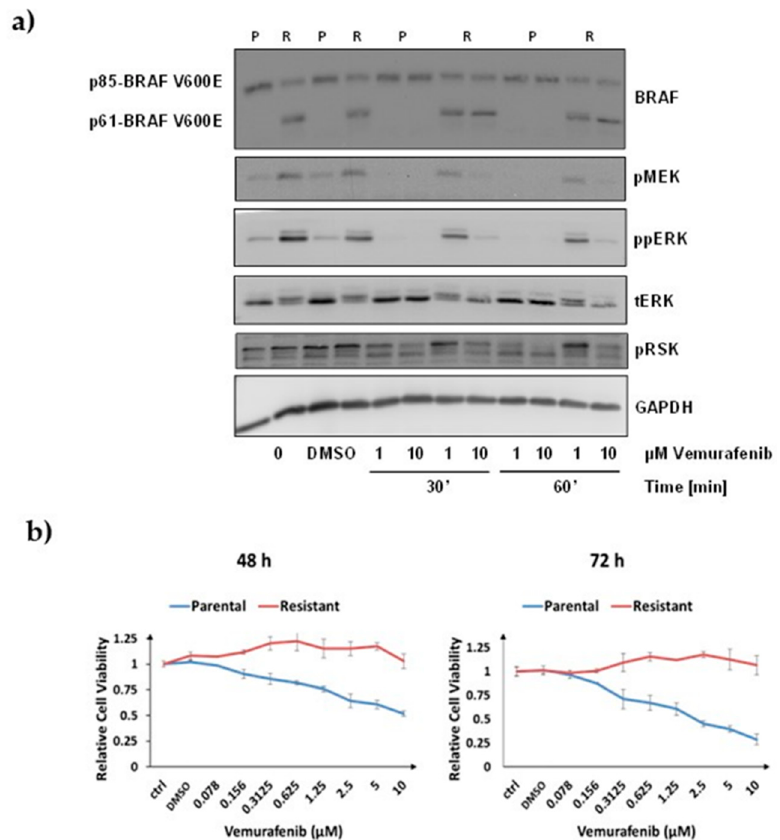
Figure 1. Characterisation of the cell line model system. ( a ) Western blot of ERK signalling in response to vemurafenib treatment. Treatment doses and timepoints in parental (P) and resistant (R) SK-MEL-239 cells are indicated below the image. p85-BRAF indicates full-length BRAF V600E of 85 kDa, and p61 the short splice variant of 61 kDa. ( b ) Relative cell viability measured by MTS assay in response to different doses of vemurafenib treatment for 48 h and 72 h, as indicated. ctrl: No treatment, DMSO: DMSO added, numbers: different concentrations of vemurafenib added as indicated.